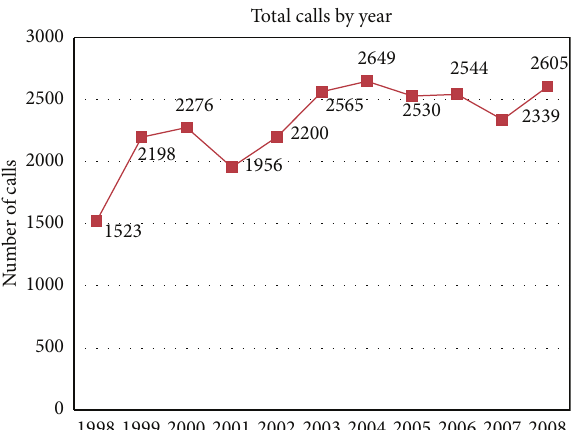
Figure 1: Total calls to the toll-free line, by year 1998–2008. The total number of calls received by the toll-free service increased gradually over the first five years then remained relatively stable at about 2500 (+/ − 100) calls per